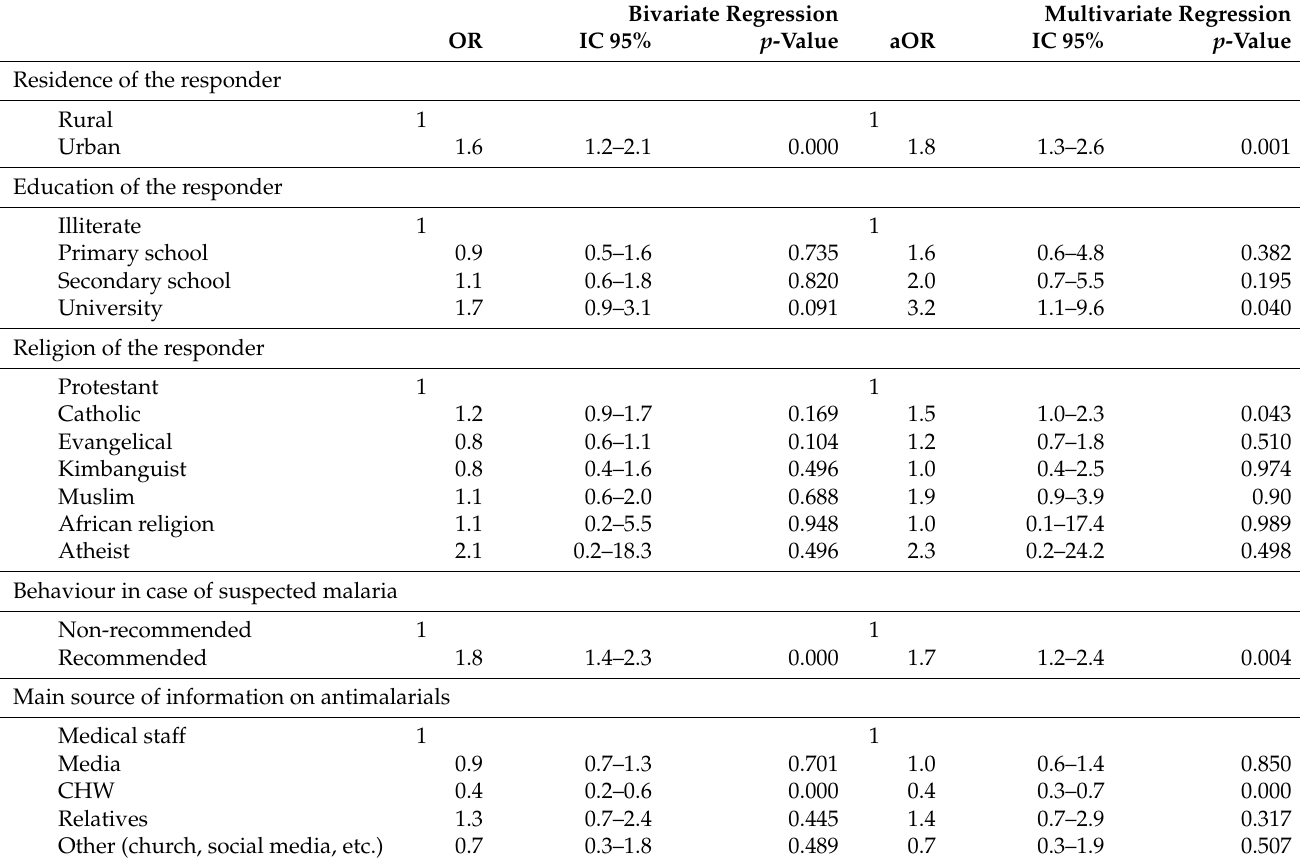
Table 5. Determinants of treatment